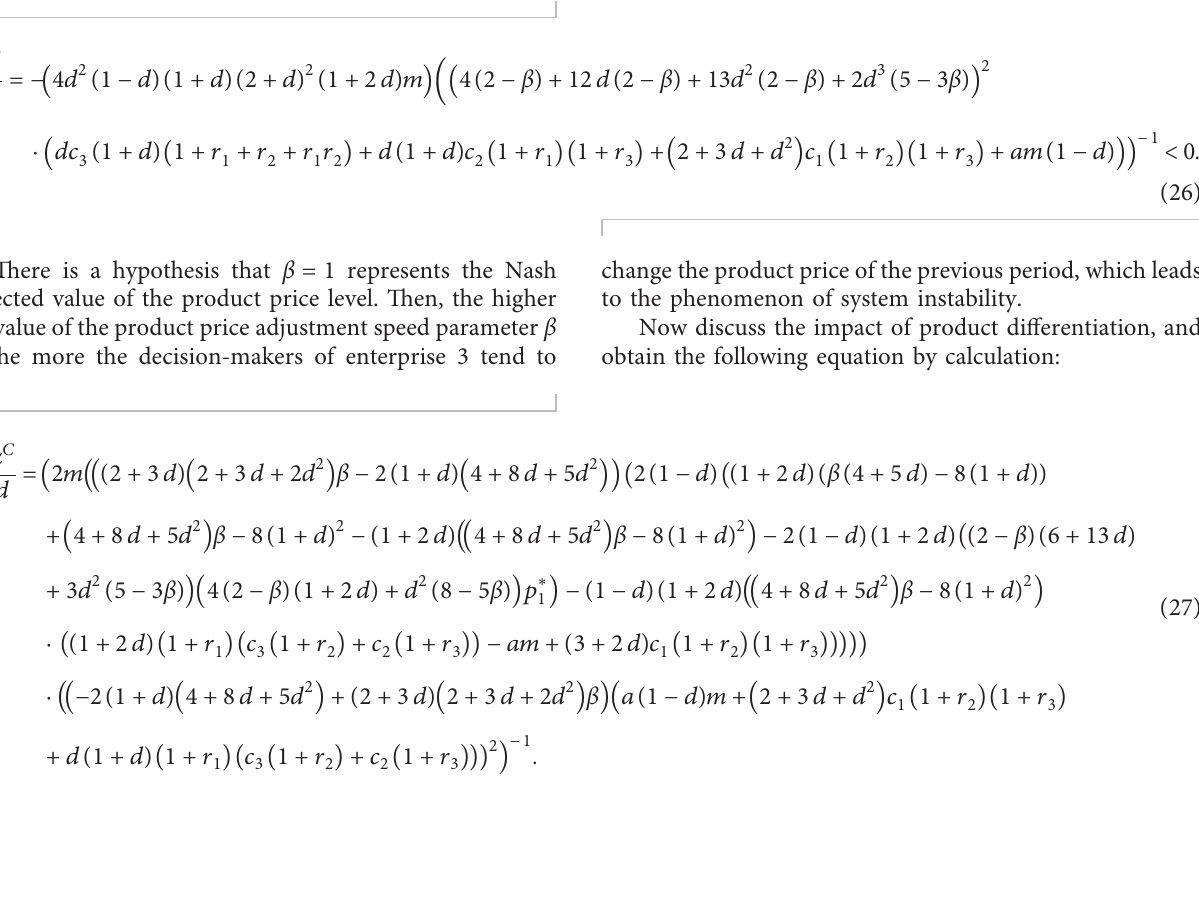
changes with the change of ( d, β ) 2